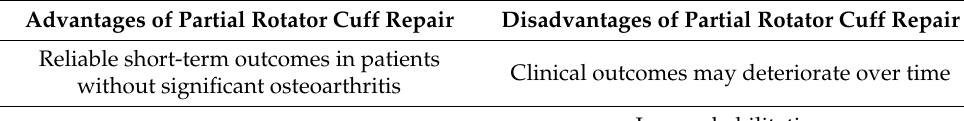
Table 3. Advantages and disadvantages of partial rotator cuff repair.